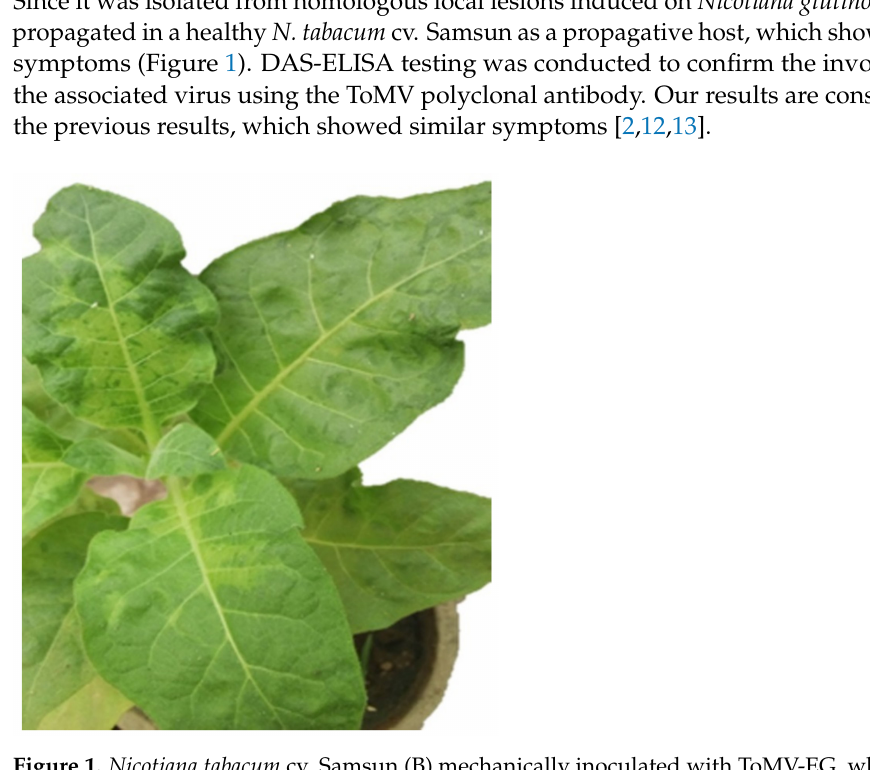
Figure 1. Nicotiana tabacum cv. Samsun (B) mechanically inoculated with ToMV-EG, which showed mosaic